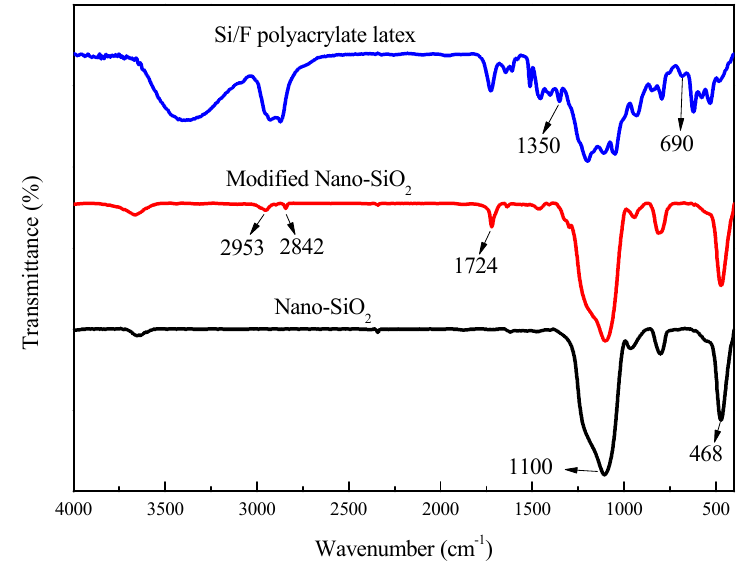
Figure 2. FT-IR spectra of Nano-SiO2, modified Nano-SiO2, and Si/F polyacrylate latex.